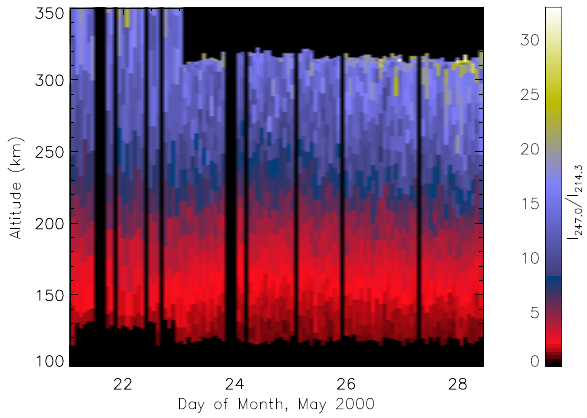
Fig. 4. Ratio of 247.0 to 214.3nm intensities measured by ISAAC and shown in the two images in Fig.